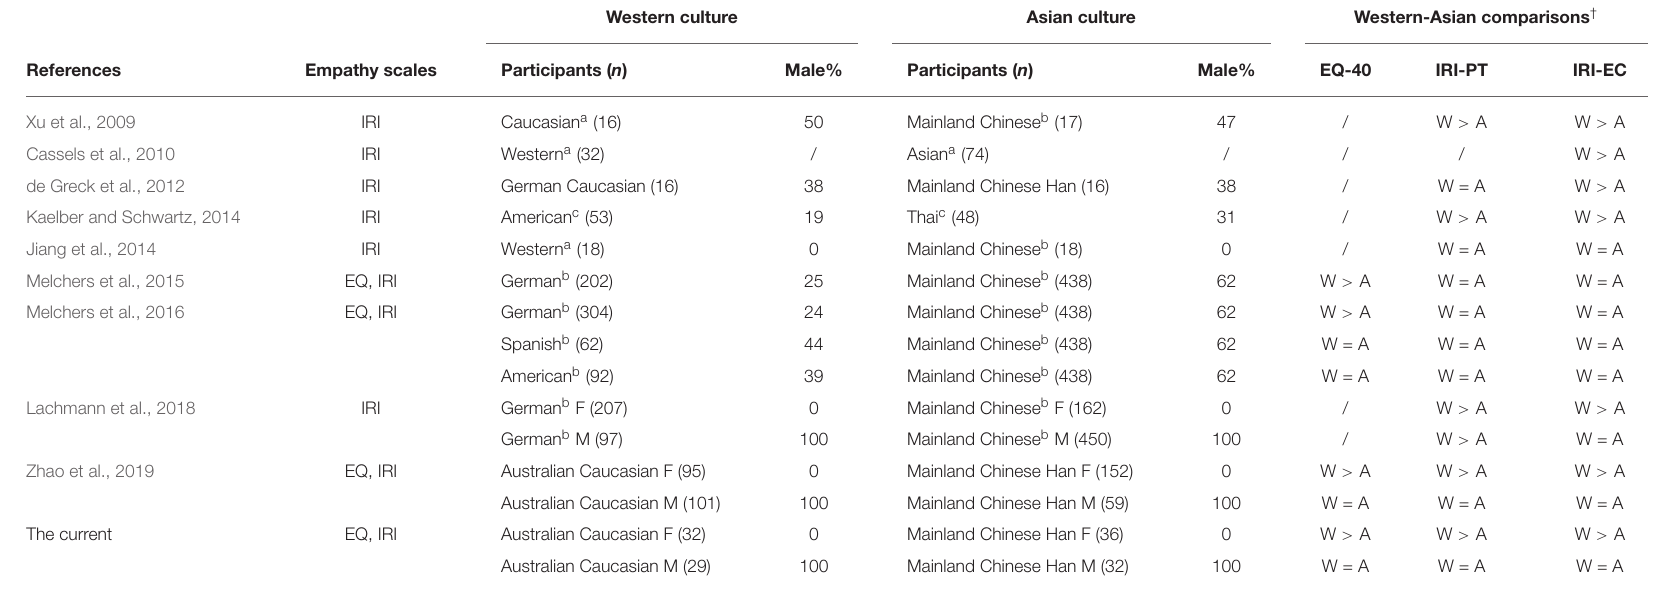
TABLE 1 | A literature review of Western-Asian cross-cultural comparisons of trait empathy using self-report